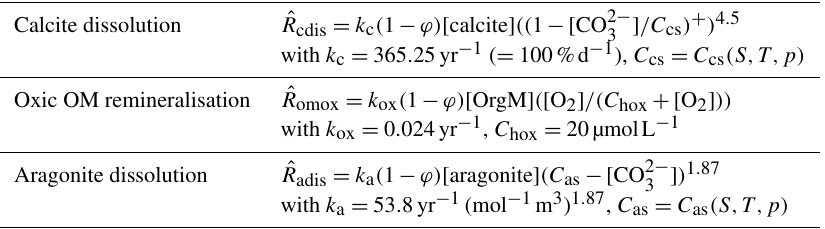
Table 3. Reaction rate law expressions and parameter values used for the MBM experiments. C cs is the CO 2 − saturation with respect to calcite and C as that for aragonite; C hox is the half-saturation concentration of O 2 for the oxic remineralisation of organic matter. (...) + denotes the positive part of (...) . The different reaction rates, ˆ R , are expressed in terms of the dissolving–remineralised solid in kg(m 3 total sediment) − 1 . Concentrations of solids are expressed in kg(m 3 solid sediment) − 1 , and those of solutes are expressed in mol(m 3 pore water) − 1